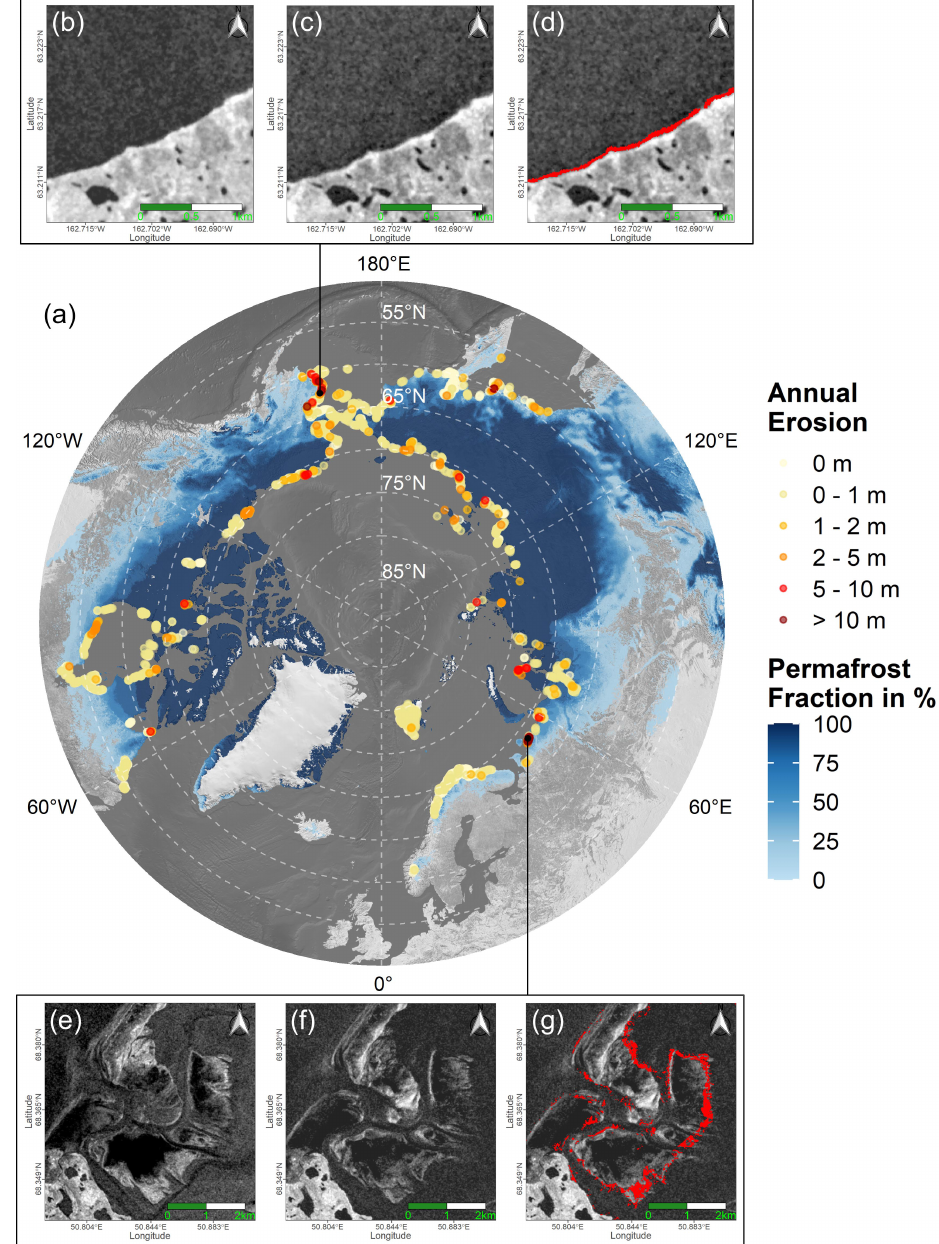
Figure 11. Circum-Arctic overview ( a ) and zoom-ins ( b – g ) on Change Vector Analysis (CVA)- based Arctic coastal erosion rates. The annual average erosion for 20 km segments is shown in ( a ). The median backscatter in vertical-vertical (VV) polarization from June–September in 2017 ( b , e ), 2021 ( c , f ), and again 2021 with the CVA-based erosion area ( d , g ) in red is shown for a coastal area in Alaska ( b – d ) and a sandy delta in Russia ( e – g ). The permafrost fraction across the Northern Hemisphere for the year 2017 based on data by Obu et al. [52] in combination with a shaded relief by Natural Earth [58] was utilized as a background map for ( a